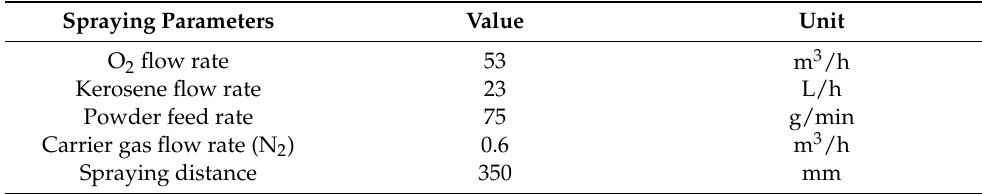
Table 2. Spraying parameters of HVOF.